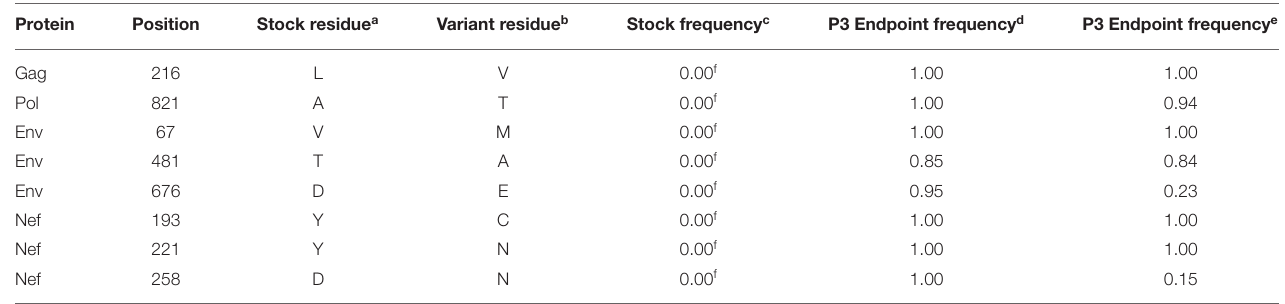
TABLE 1 | Amino acid substitutions accumulated during three passages of SIVmac239 in hu-mice.